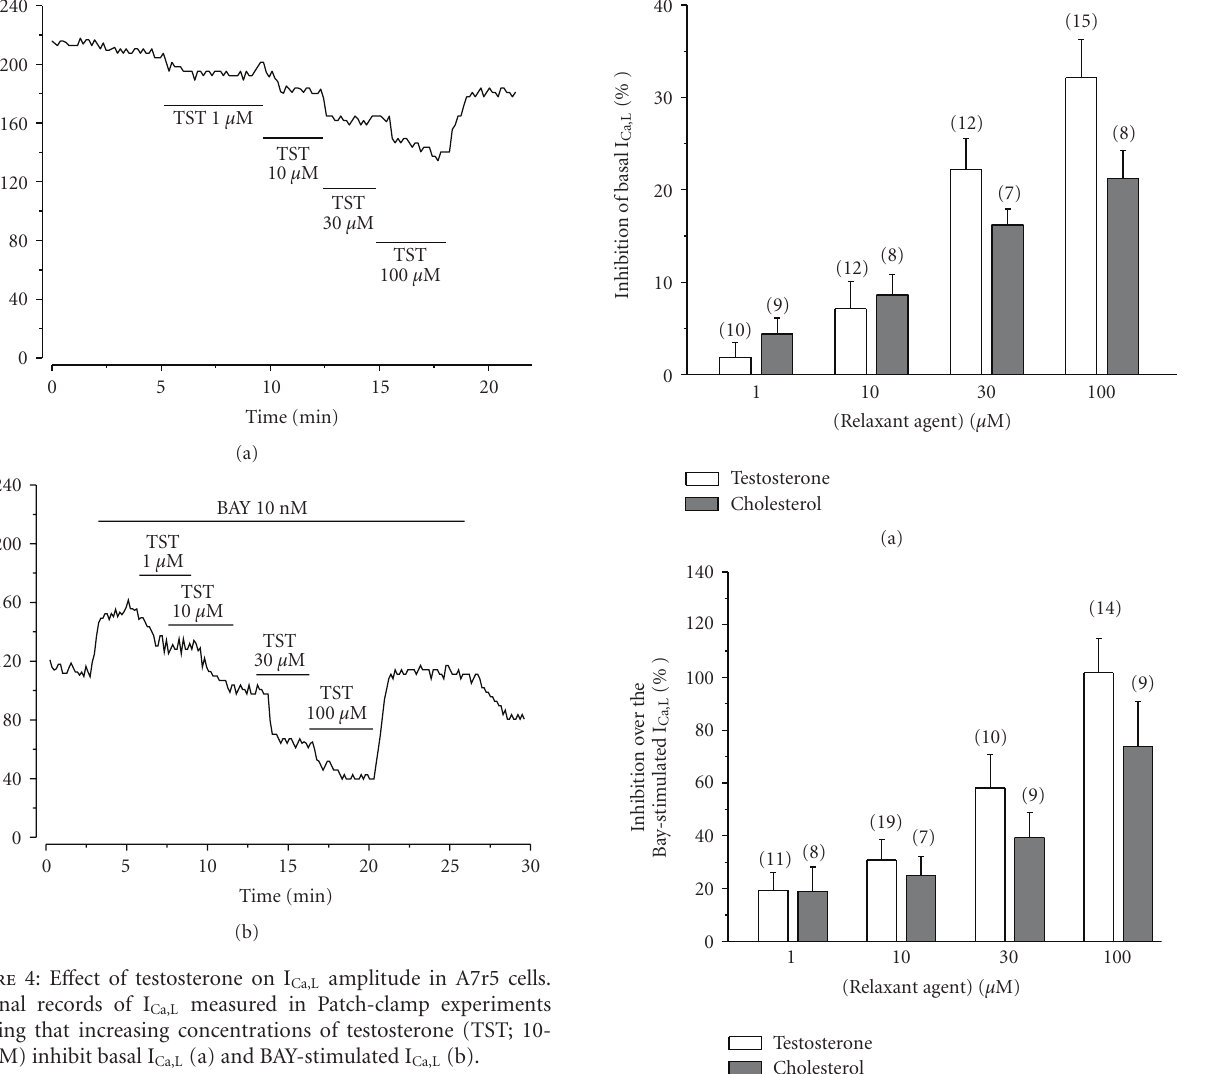
proteins, like the sex hormone binding globulin (SHBG).